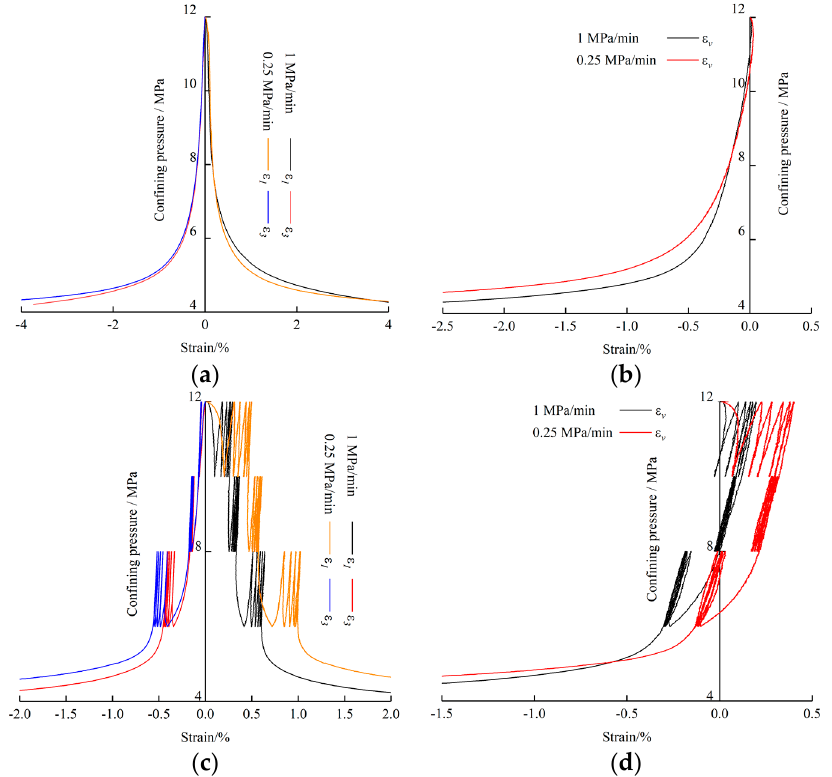
Figure 7. Stress–strain curves under different unloading rates: ( a ) axial and radial strains of B-1 and B-2; ( b ) volume strain of B-1 and B-2; ( c ) axial and radial strains of C-1 and C-2; ( d ) volume strain of C-1 and C-2.